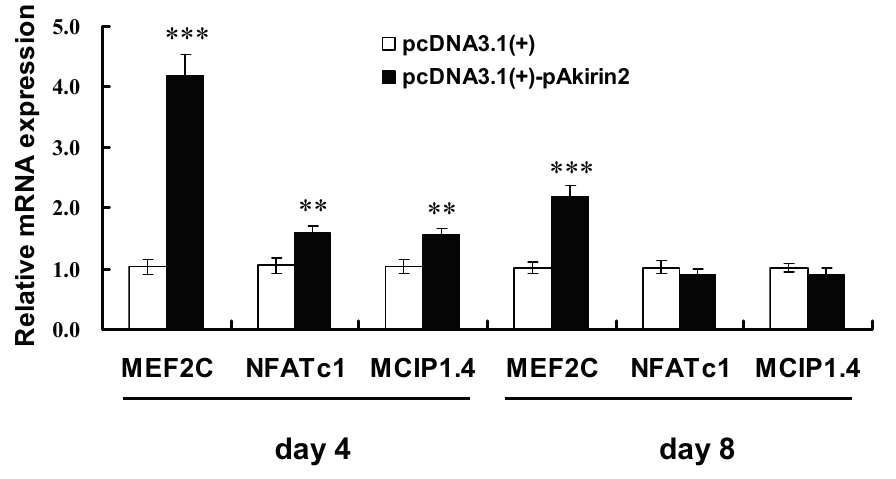
Figure 4. Effect of pAkirin2 on oxidative muscle fiber gene expression in C2C12 myotubes. C2C12 myoblasts were cultured and transfected as in Figure 2. After a transfection of 4 and 8 days, the mRNA levels of MEF2C , NFATc1 and MCIP1.4 were determined